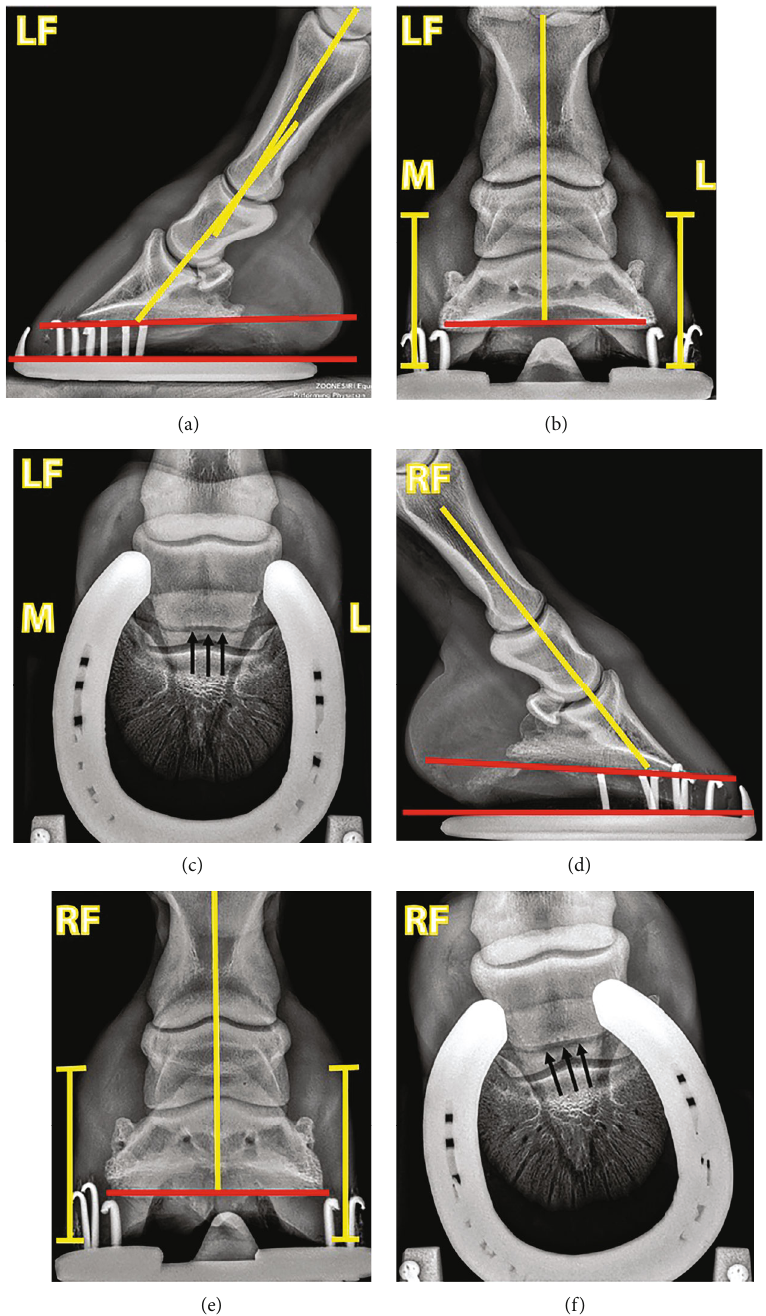
Figure 5: Radiographic images of the (a – c) left and (d – f) right front hooves of a show jumping pony at 30 weeks of shoeing management. The left front hoof demonstrated an improvement in the hoof-pastern axis after a given period of management (a), while a positive hoof angle was still observed in the right front hoof but displayed a lower degree than before shoeing management (d). Hoof ’ s balance was also corrected in both front hooves (b, e). A slight irregularity of the navicular bone ’ s ventral border was still marked in both front hooves (c,